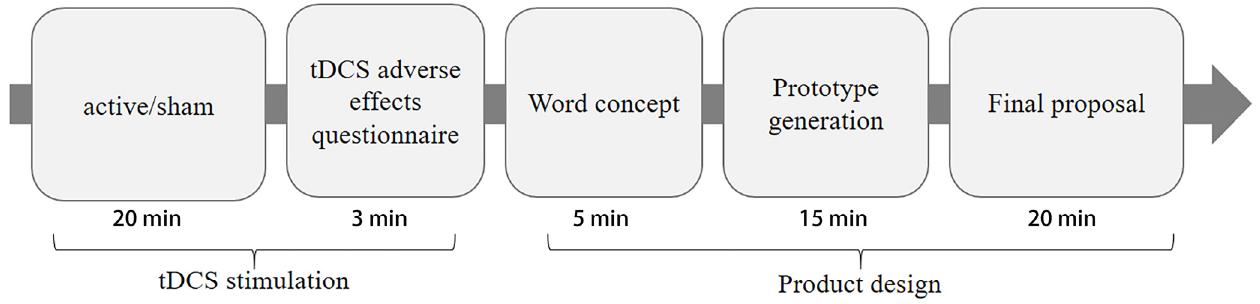
Figure 2. Experimental procedure.